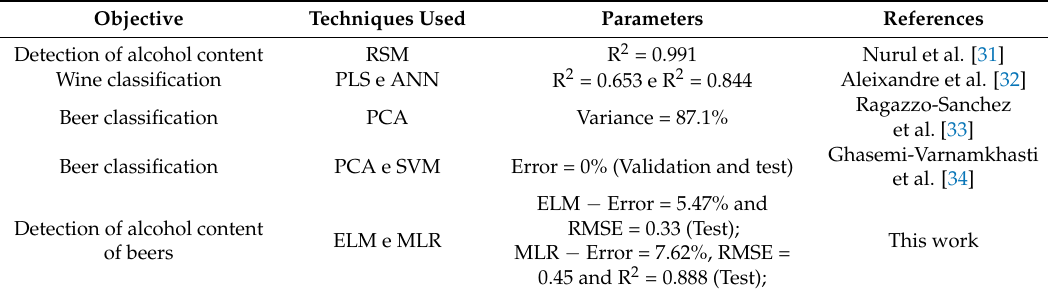
Table 8. Summary of results of related work on the classification of